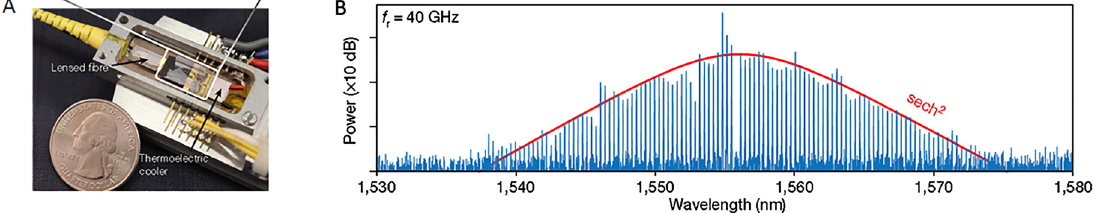
Figure 9: Integrated turnkey soliton micro-comb with the repetition frequency at electronic-circuit rates. (A)ImageoftheDFBpumplaserandmicro-combchipsetmountedinacompactbutterflypackage.(B)Opticalspectrumofasinglesolitonstate with the repetition frequency of 40 GHz. Reprinted (adapted) with the permission from Ref. [102], Copyright 2020, Springer